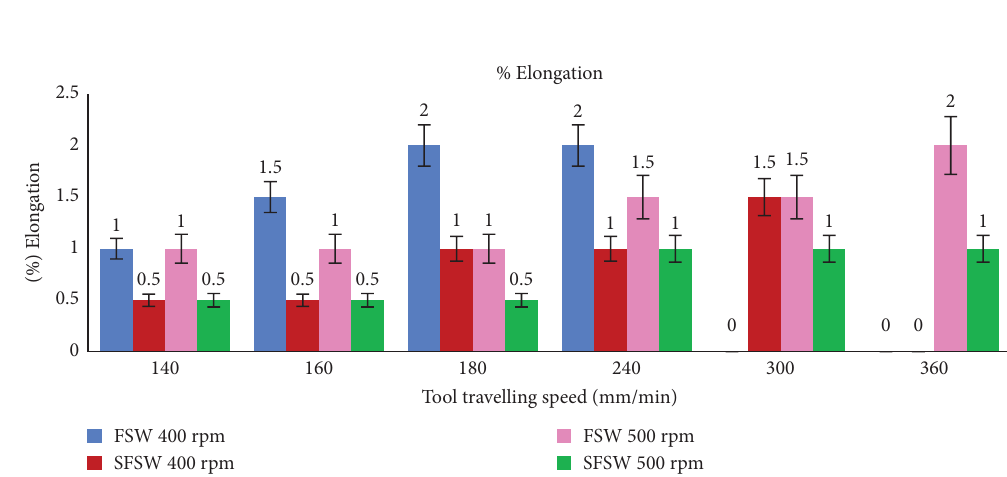
Figure 6: Tensile strength of the welded joints.